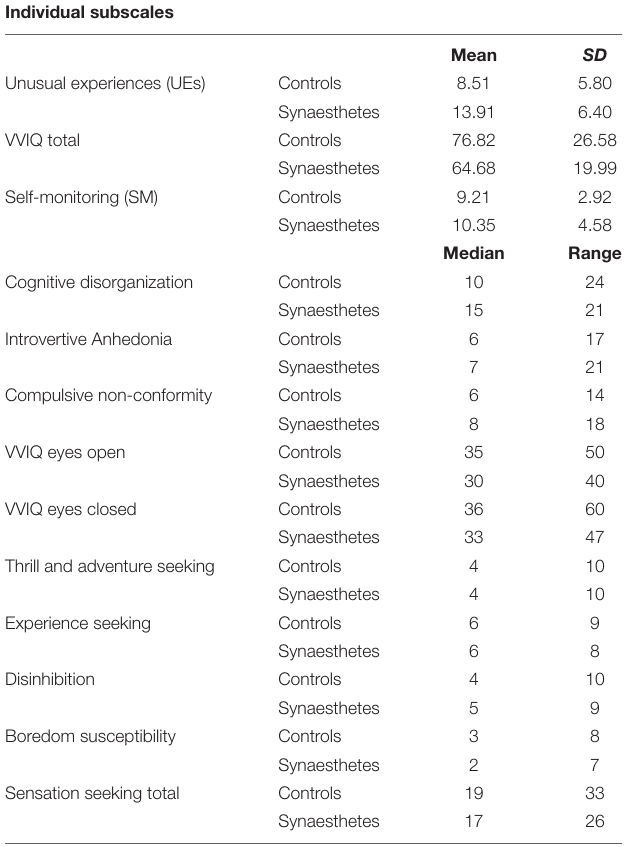
TABLE 1 | Means and Standard Deviations for normally distributed individual subscales of O-Life, VVIQ, SSS-V and SM, and Medians and Ranges for subscales which were not normally